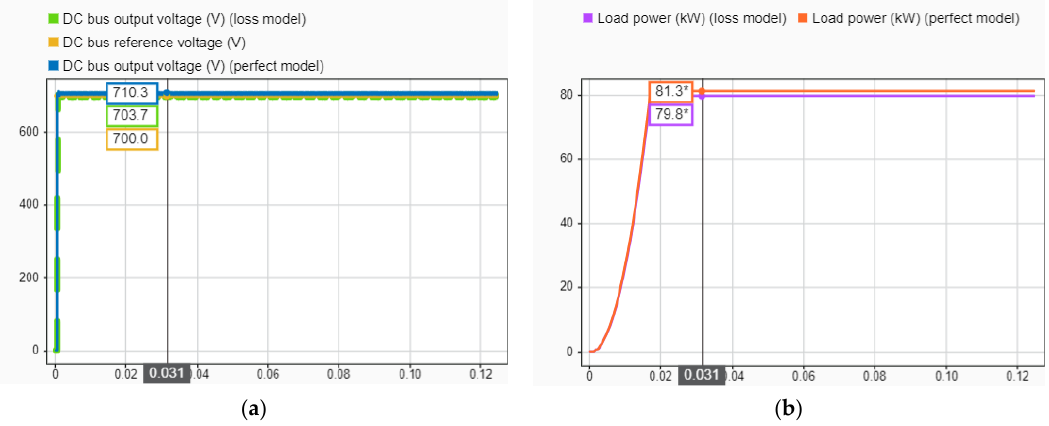
Figure 9. Output voltage and load power for 40 kW using perfect model and conduction loss model for DAB DC-DC converter: ( a ) DC bus output voltage; ( b ) load power.